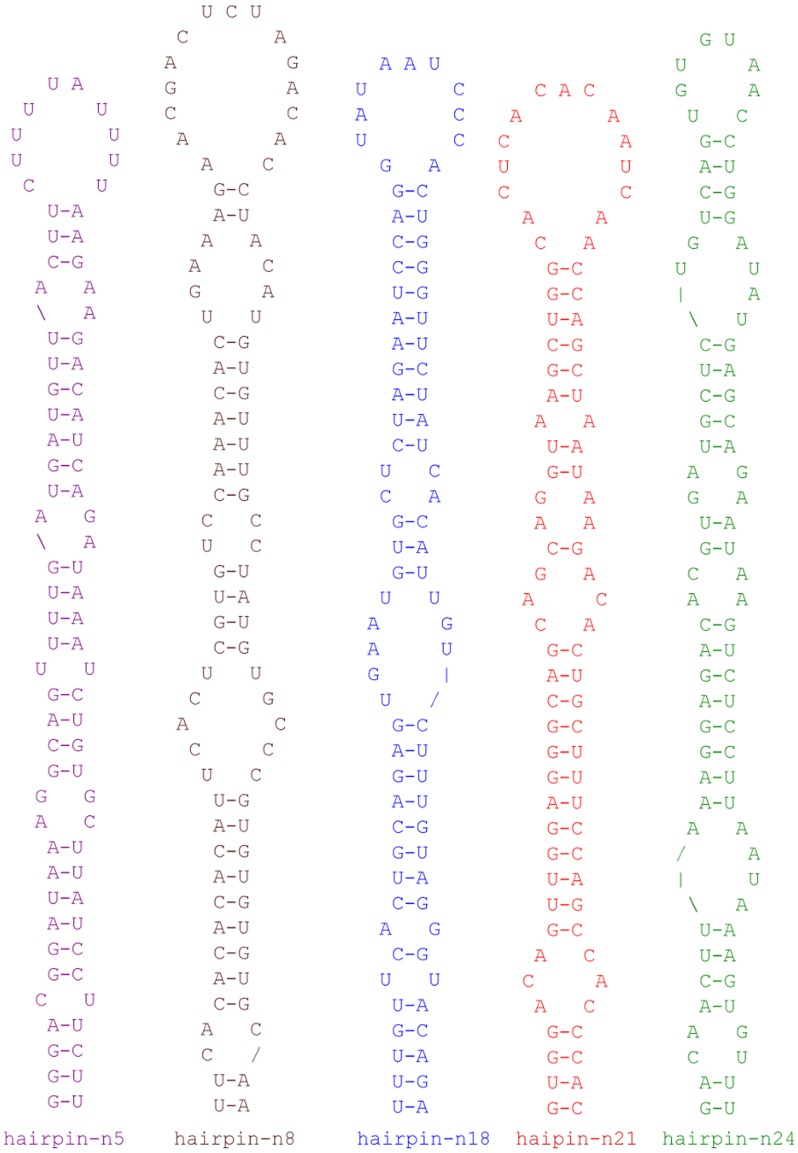
Predicted secondary structure of selected five miRNA hairpins from Atlantic halibut 454 genome sequences.For the secondary structure and corresponding free energy (ΔG in kcal/mol) of all predicted precursors, see Dataset S3.